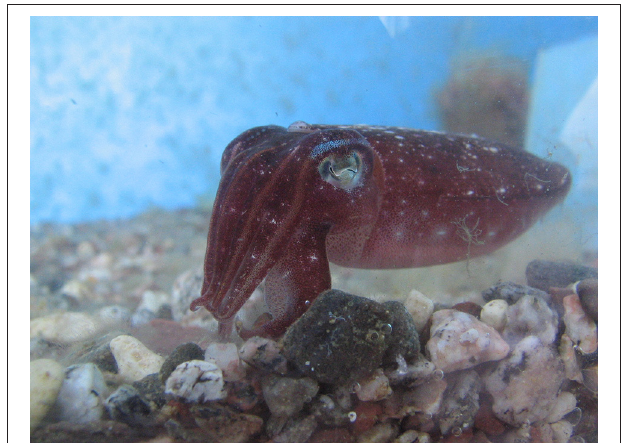
FIGURE 1 | Eyes of the cuttlefish Sepia elongata caught off the coast of Eilat (Gulf of Aqaba, Israel; photo AS Darmaillacq).